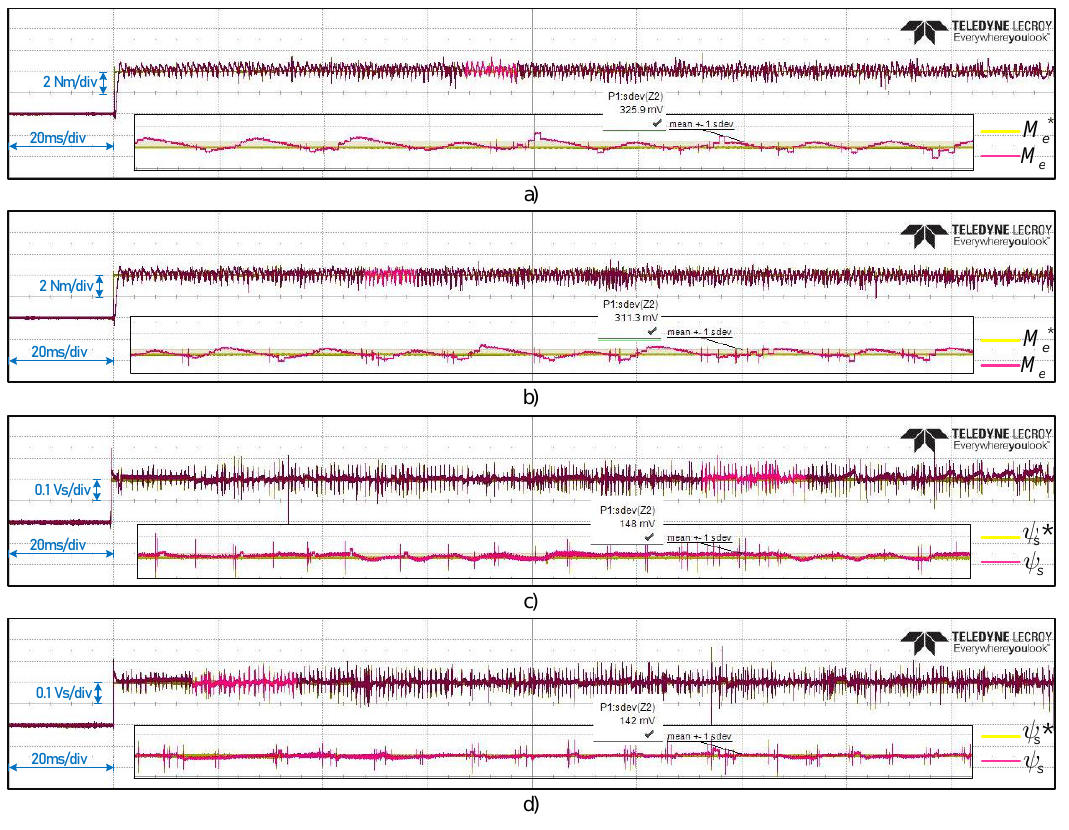
Figure 8. Experimental results under parameter variation of 50% from nominal parameters. ( a ) Electromagnetic torque conventional deadbeat control. ( b ) Stator flux conventional deadbeat control. ( c ) Electromagnetic torque proposed deadbeat control. ( d ) Stator flux proposed deadbeat